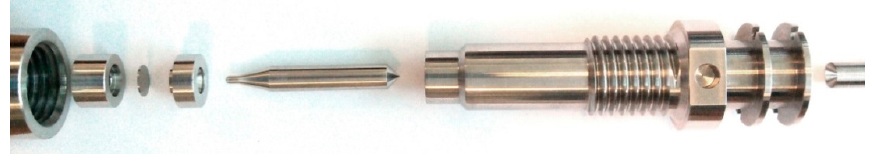
Figure 8. Small Punch test configuration.